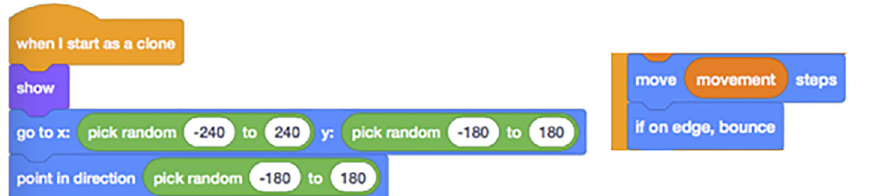
Figure 14. Coding blocks for illustrating the movements step in